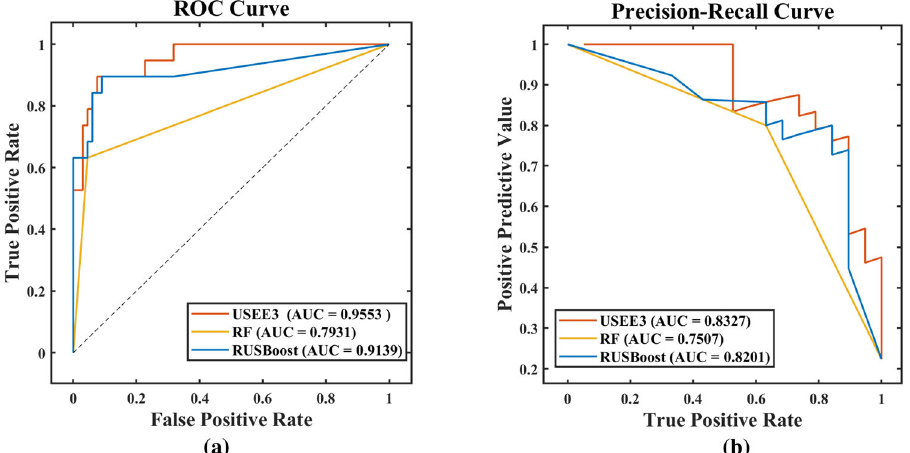
Fig. 3 Comparison of the classi fi cation effects of various methods. Only test set results are shown. a ROC Curve, b Precision-Recall